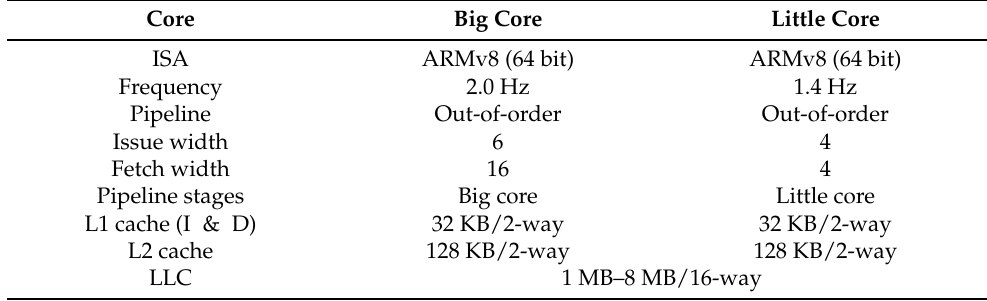
Table 1. Baseline